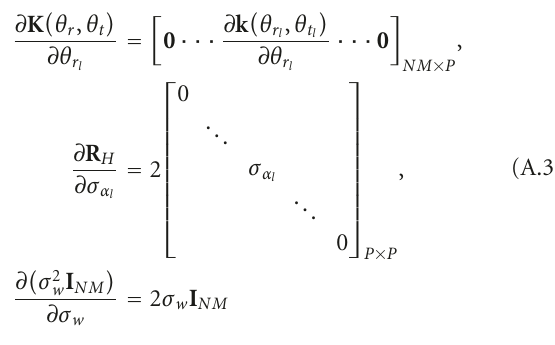
= 0 . 7, σ 2 = 0 . 75, σ 2 = 0 . α 1 α 2 α 3